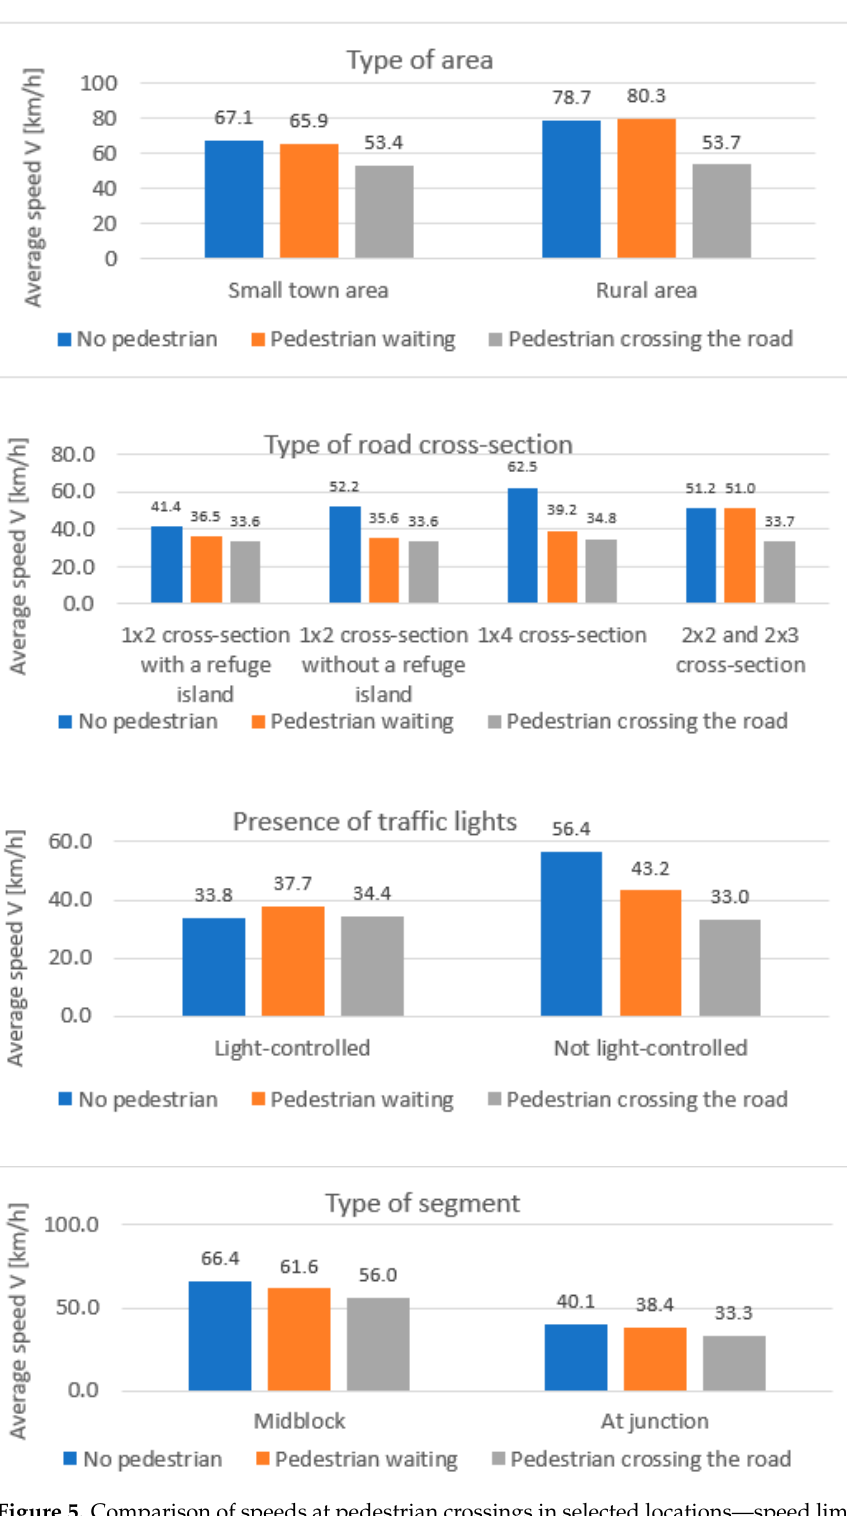
Figure 5. Comparison of speeds at pedestrian crossings in selected locations—speed limit of 50 km/h (measured at 50 m from the crossing).